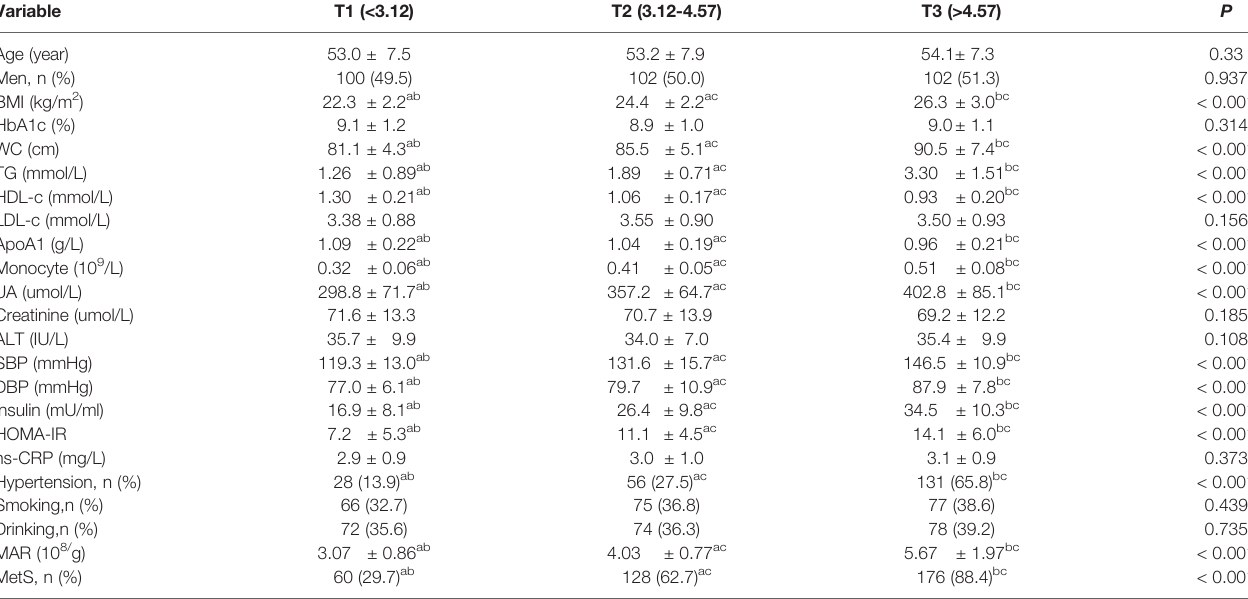
TABLE 2 | Clinical and laboratory characteristics of participants based on tertiles of MHR (10 8 /mmol). Variable T1 (<3.12) T2 (3.12-4.57) T3